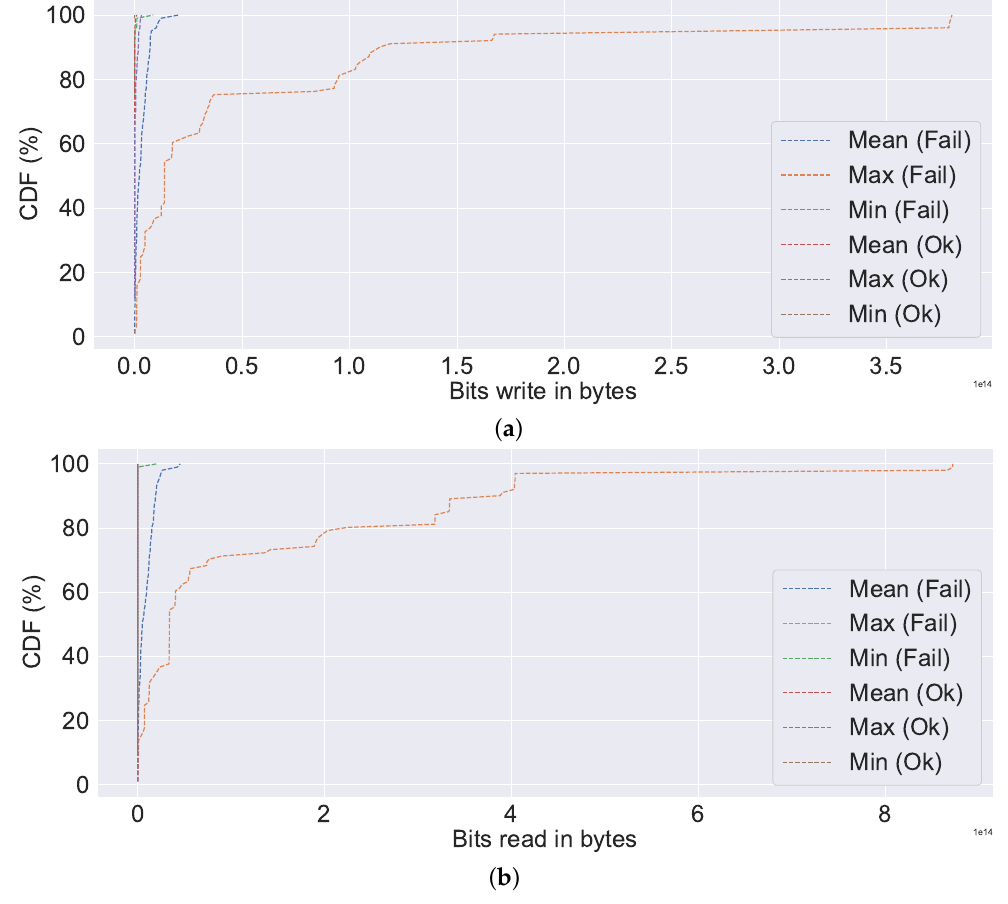
Figure 13. Visualisation of the CDF of bits write and bits read. ( a ) CDF of bits write; ( b ) CDF of bits read.